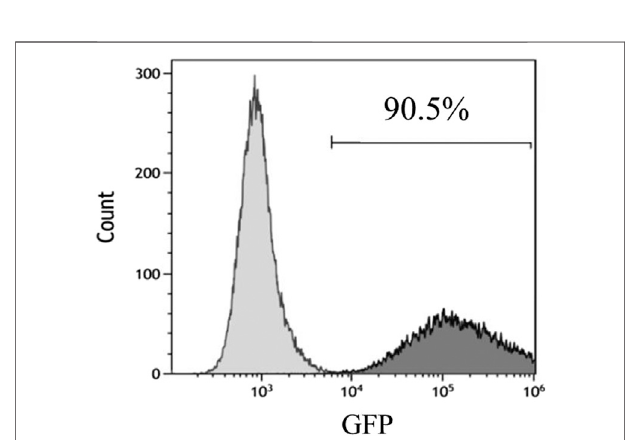
Frontiers in Pharmacology |